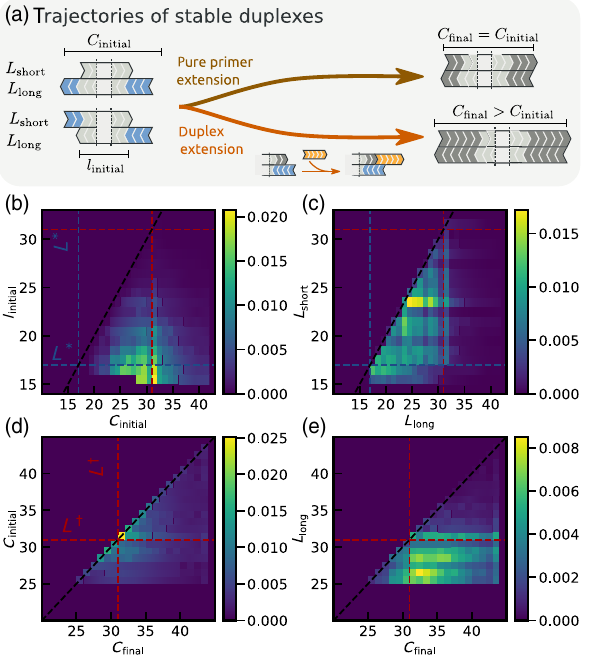
FIG. 6. (a) Trajectories start with an initial stable duplex characterized by its strand lengths L and L together with long short the initial overlap l and complex length C . Trajectories initial initial not creating new single-stranded regions beyond the initial complex are referred to as “ pure primer extension. ” In contrast, > C duplex extension leads to a final complex with C . final initial (b) – (e) Trajectory statistics can be understood from various joint probability distributions, where L (cid:1) ∼ 17 and L † ∼ 31 . See main text for details.